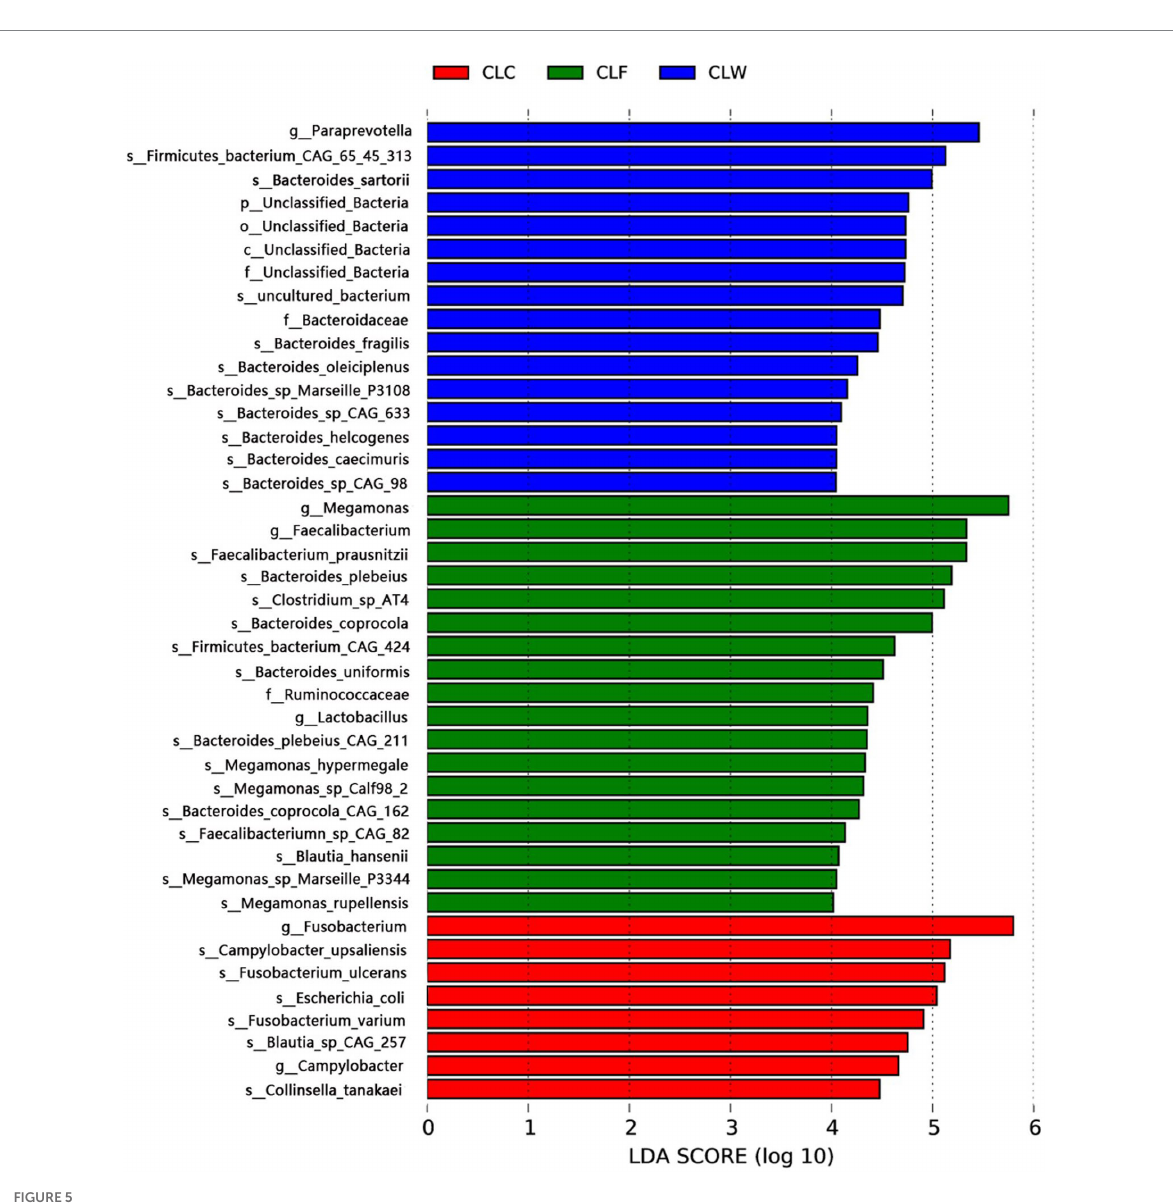
FIGURE 5 LEfSe analysis showed respective biomarkers in groups CLW, CLC and